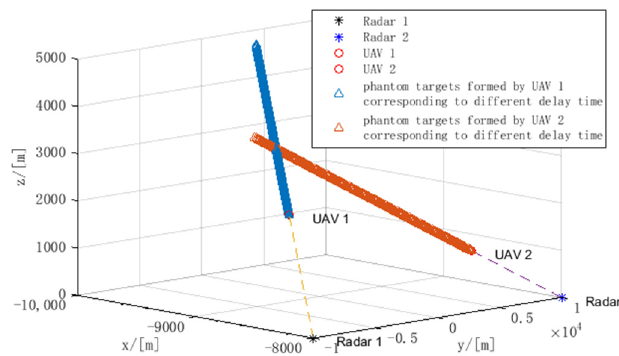
Figure 7. The phantom targets formed by two UAVs with different delay times.